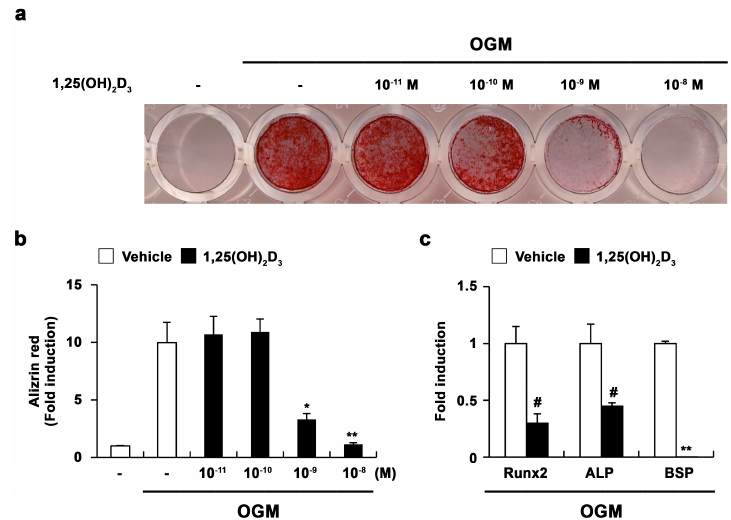
Figure 1. 1,25-dihydroxyvitamin D 3 (1,25(OH) 2 D 3 ) inhibits osteoblast differentiation. ( a – c ) Primary osteoblasts were cultured in osteogenic medium (OGM) with vehicle or increasing concentrations of 1,25(OH) 2 D 3 . ( a ) Cultured cells were fixed and stained with Alizarin red; ( b ) Alizarin red staining was quantified by densitometry at 562 nm; ( c ) Primary osteoblasts were cultured in osteogenic medium (OGM) containing either vehicle or 1,25(OH) 2 D 3 (10 − 8 M). The mRNA levels of Runx2 , alkaline phosphatase ( ALP ), and bone sialoprotein ( BSP ) were analyzed by real-time polymerase chain reaction (PCR). # p < 0.05; * p < 0.01; ** p < 0.001 as compared with controls.